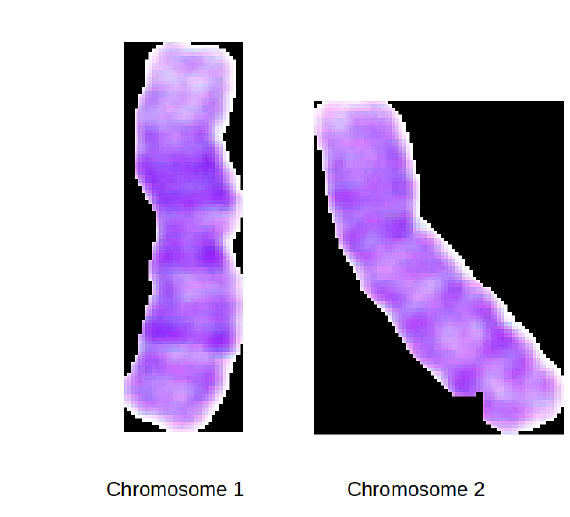
Figure 13. G-band chromosomes 1 and